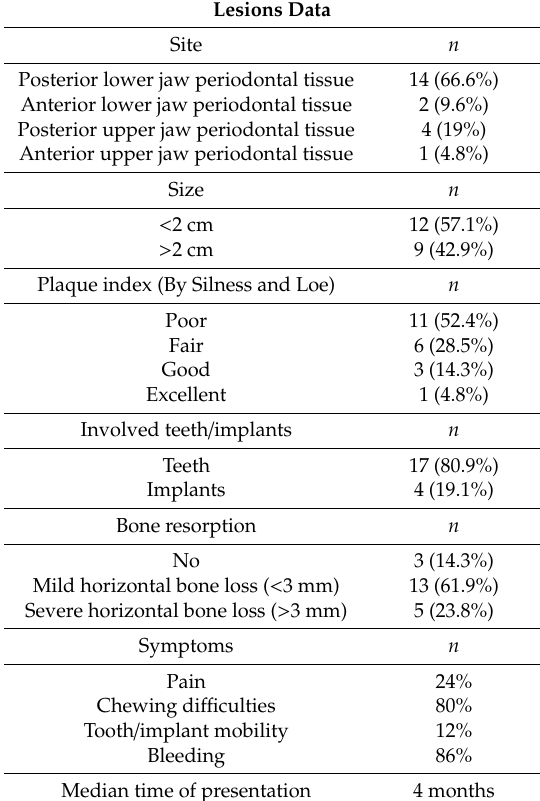
Figure 2. Clinical ( a ) and radiological ( b ) follow-up of the patient after 18 months.